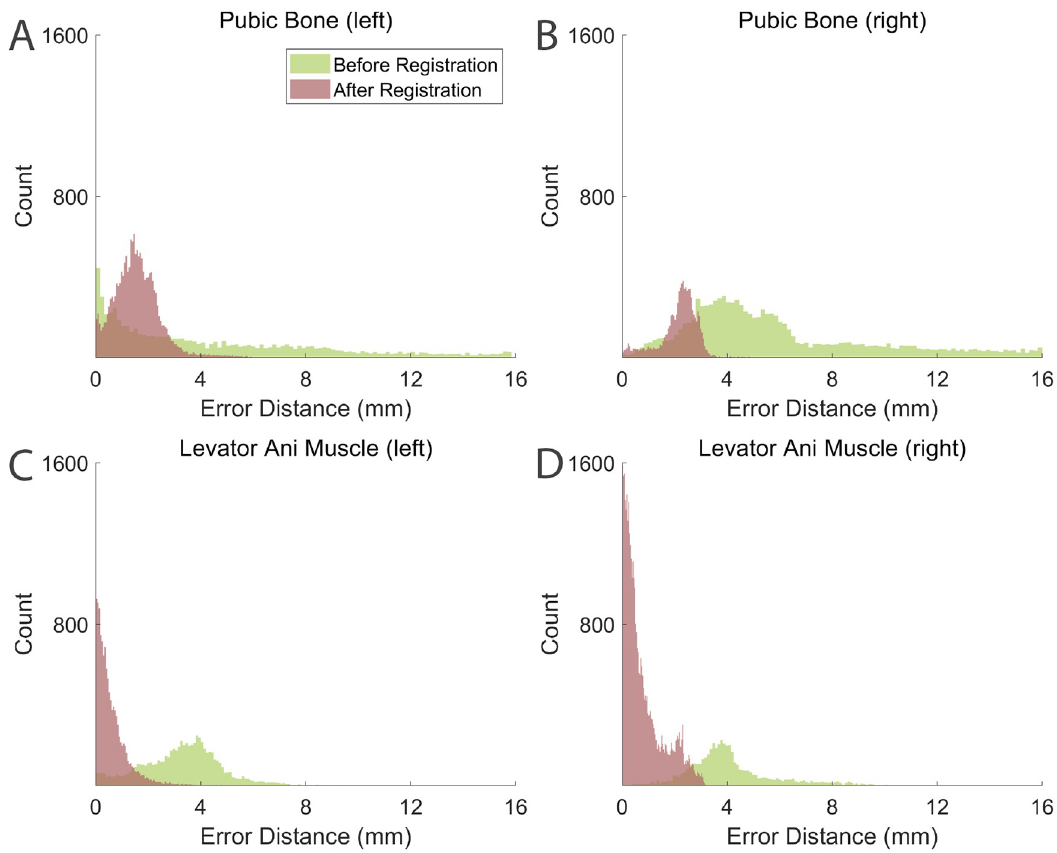
Fig 10. Comparison of histograms of error distance of pubic bone and levator ani muscle surface distances before (green) and after (red) applying M3VR. Histograms of error distance of (A) left and (B) right public bone. Histogram of error distance of (C) left and (D) right levator ani muscle surface distances.